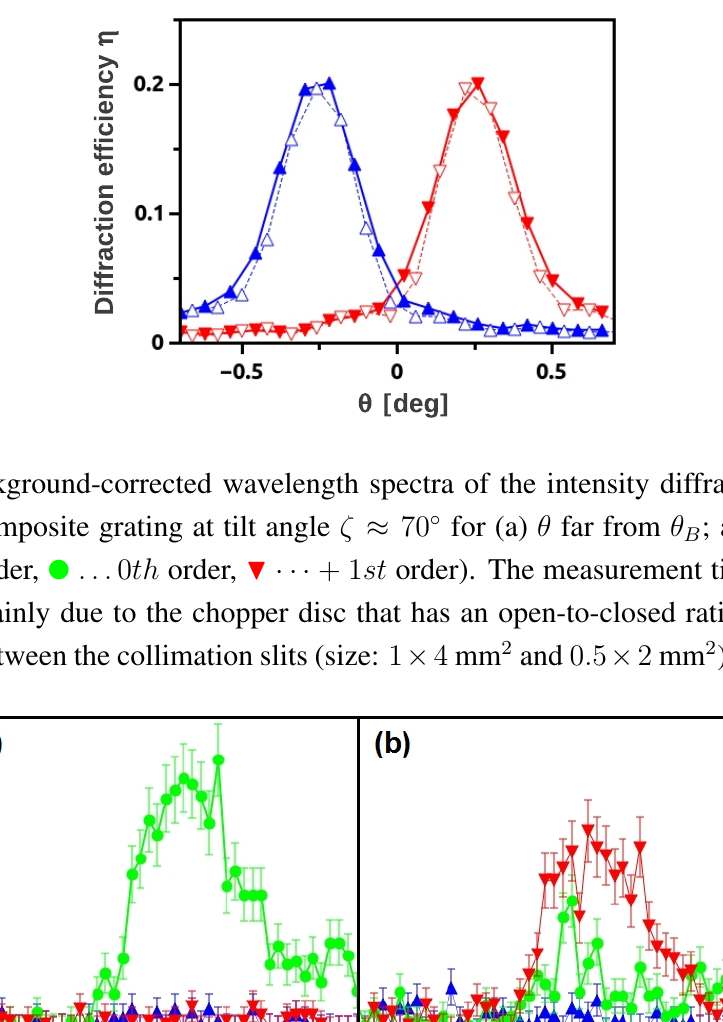
Figure 7. Rocking curve measured with λ ≈ 4 . 5 nm before ( N · · · − 1 st order, H · · · + 1 st ▽ · · · + 1 st order) removal of the covering glass plates, order) and after ( △ · · · − 1 st order,